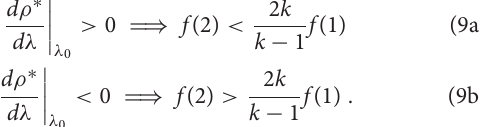
positive ( ρ ∗ = 0 intersects ρ up ), the transition is continuous, while if it is negative ( ρ ∗ = 0 intersects ρ down ), the